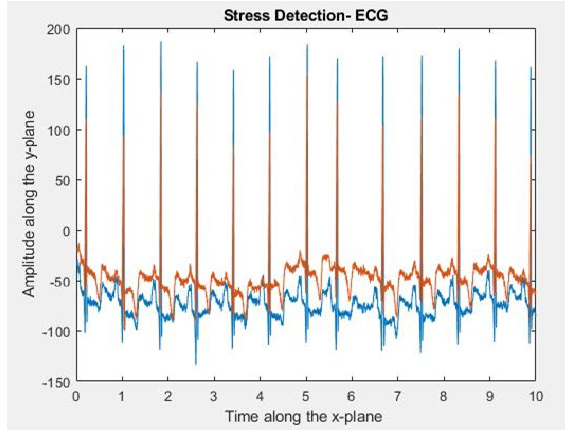
Figure 2. Wireless Body Area Network for effective passing of data